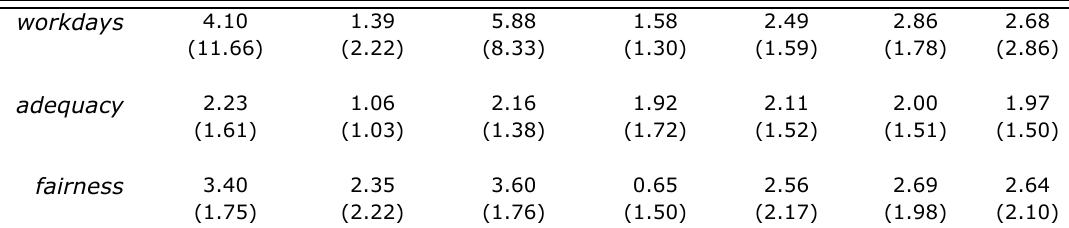
Table A 3. Response variable summary statistics.